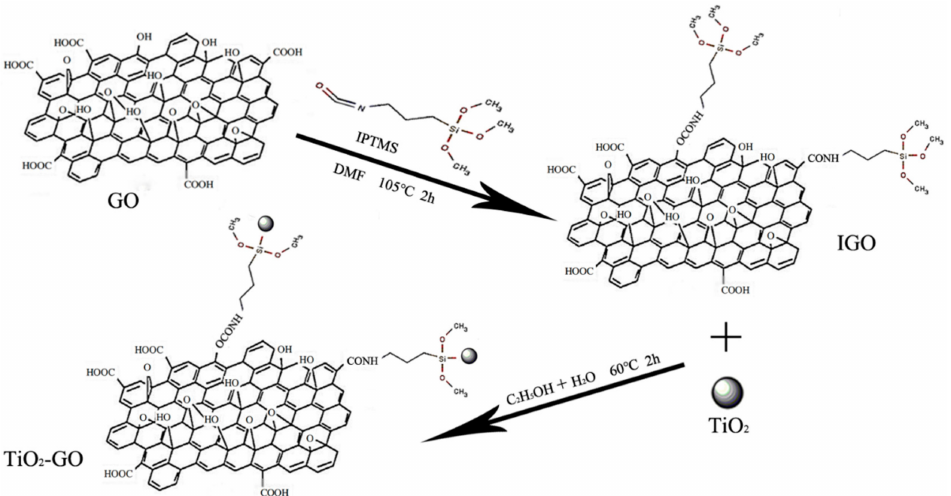
Figure 1. The mechanism of modification of graphene oxide